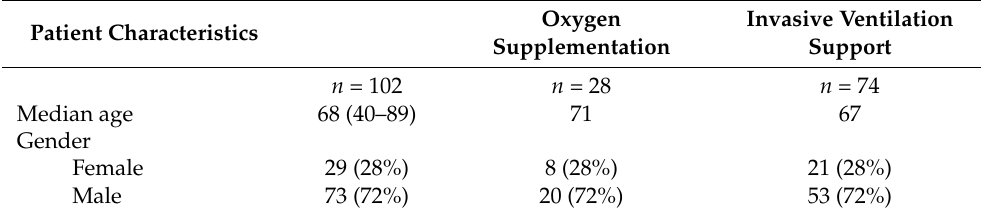
Table 2. Demographics of hospitalized patients.